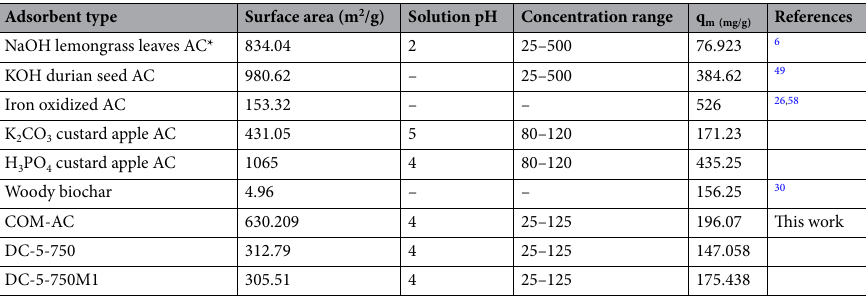
Table 10. Comparison of MR adsorption capacity with literature values. AC Activated carbon.